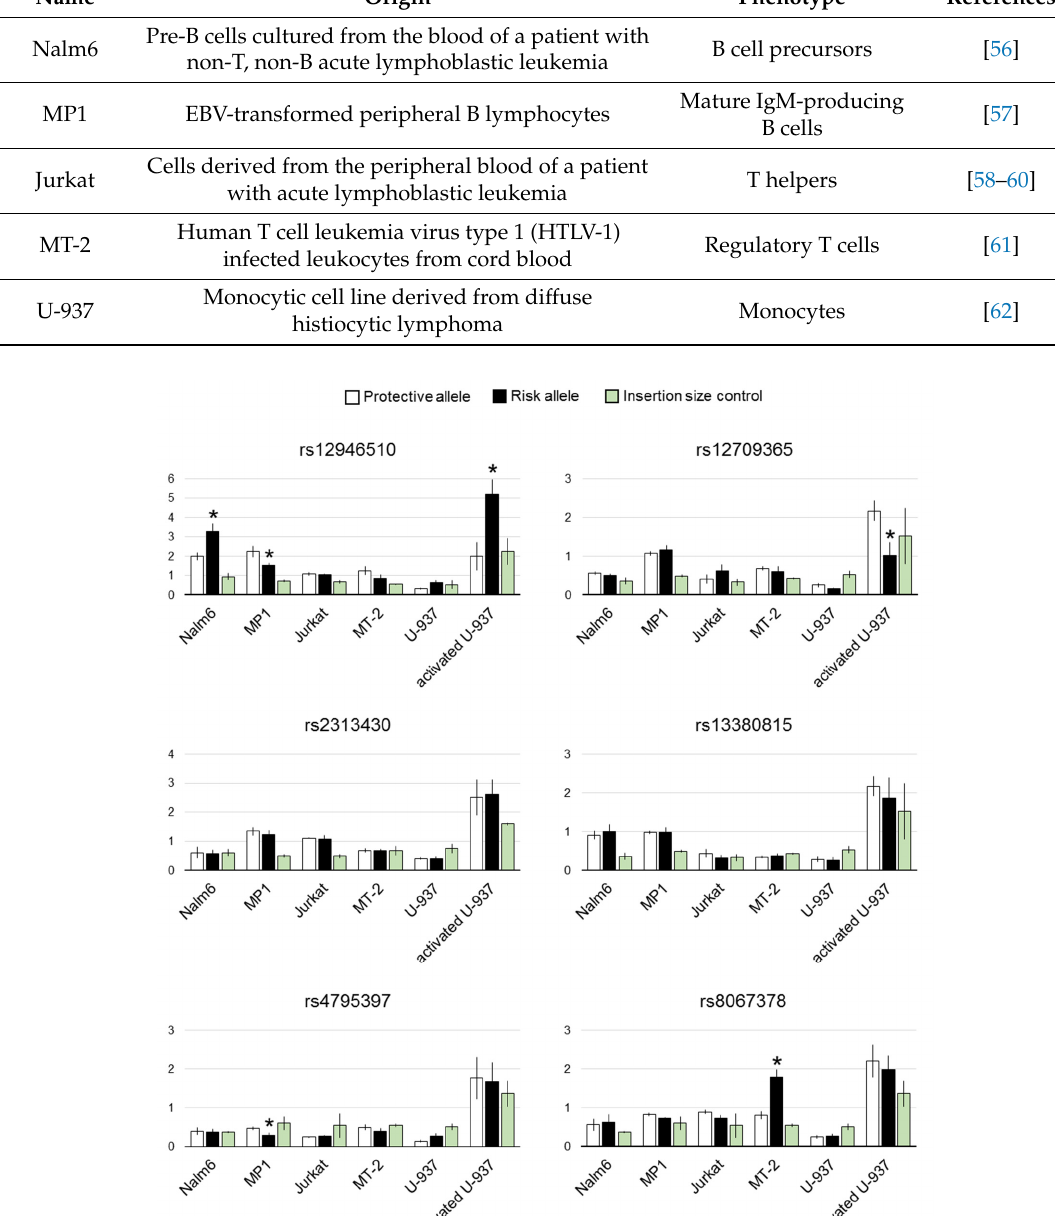
Figure 2. Effects of the candidate functional SNPs on enhancer activity in luciferase reporter